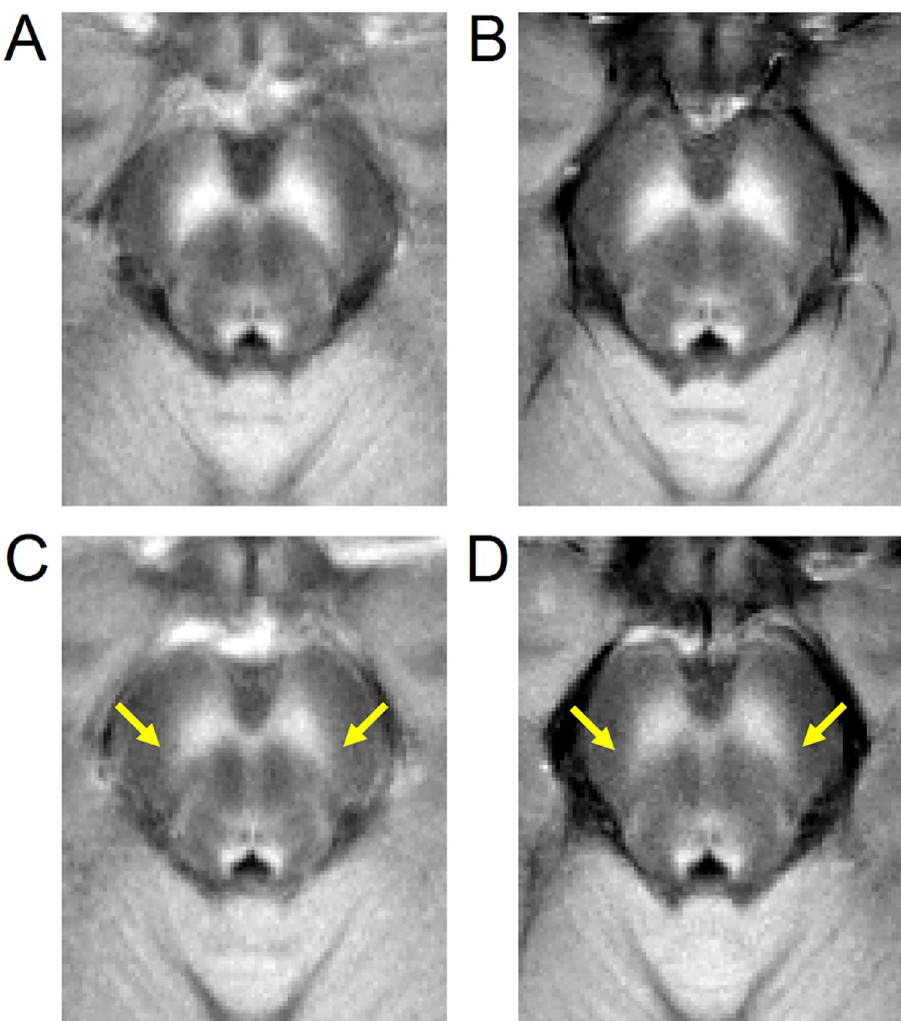
Fig 3. A comparison of mean SNc contrast in control (top row) and PD (bottom row) groups for both cohorts. Mean MTC images from cohort 1 are shown in the left column while mean MTC images from cohort 2 are shown in the right column. For each group, the mean MTC image was created by transforming MTC images from individual participants to MNI space and then averaging. Regions experiencing PD-related neuronal loss are indicated by yellow arrows in the bottom